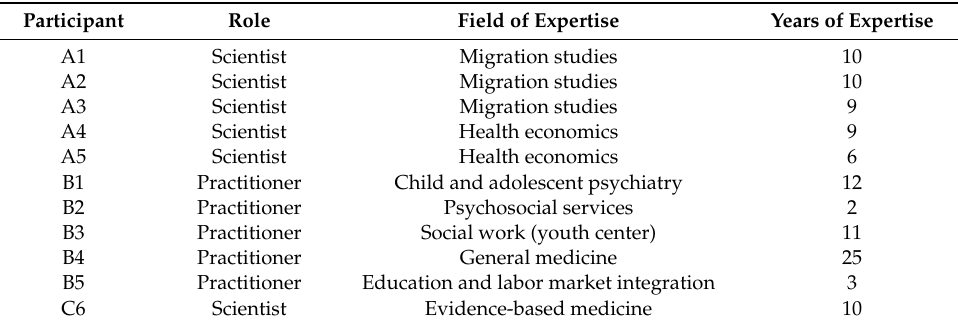
Table 1. Participants from workshop 1 to workshop